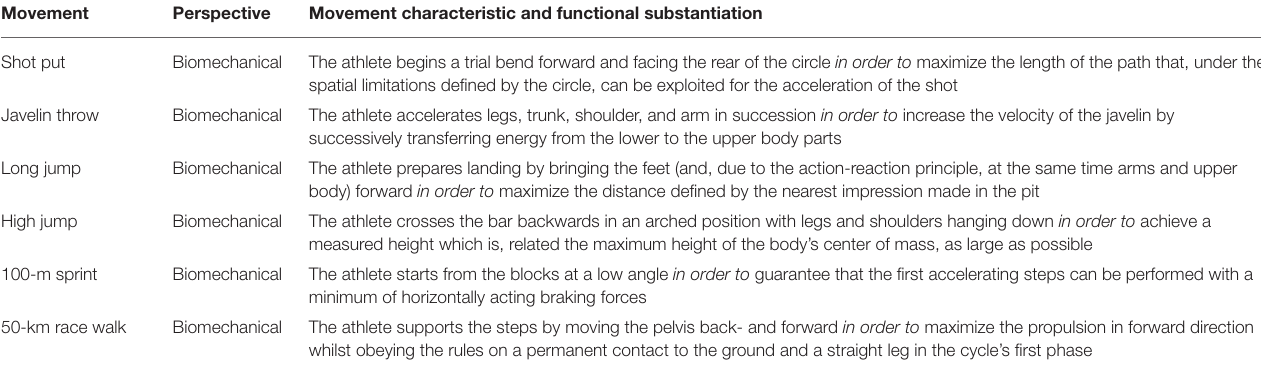
TABLE 1 | Biomechanically substantiated characteristics of sports movements. Movement Perspective